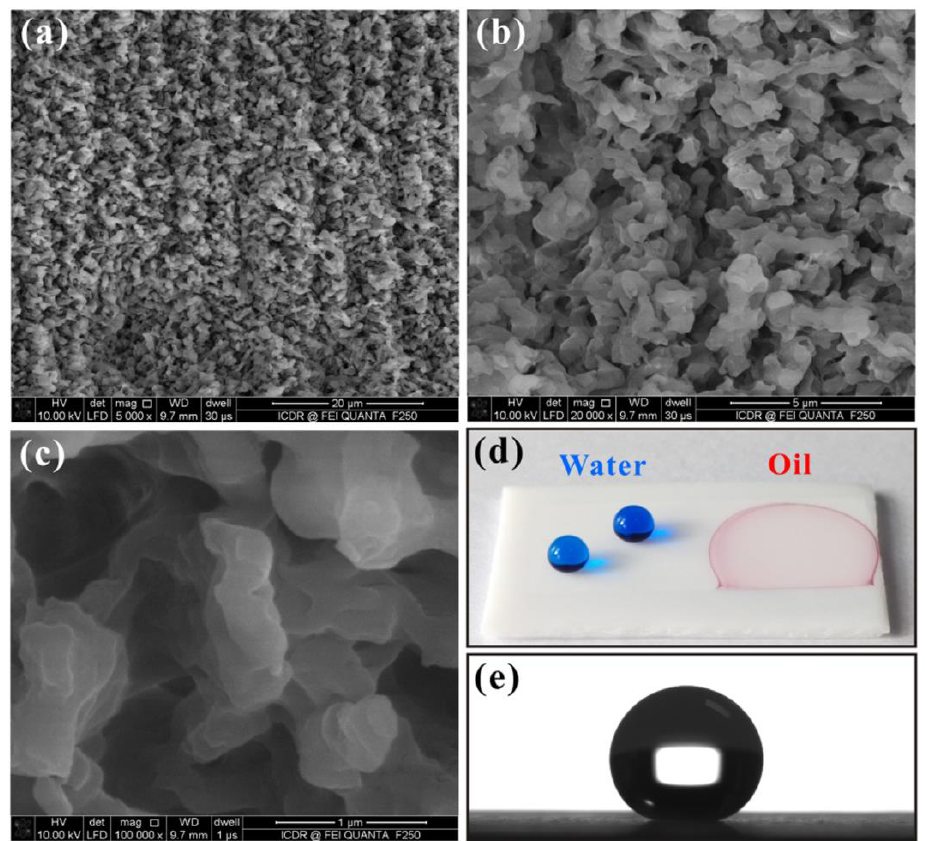
Figure 10. ( a – c ) SEM of FS laser surface structures on the PTFE surface at different magnifications. ( d ) Image of a water droplet and oil droplet on the PTFE structured surface. ( e ) Water contact angle measurement of the PTFE laser-structured surface [68]. Reproduced with permission from Elsevier 2016.